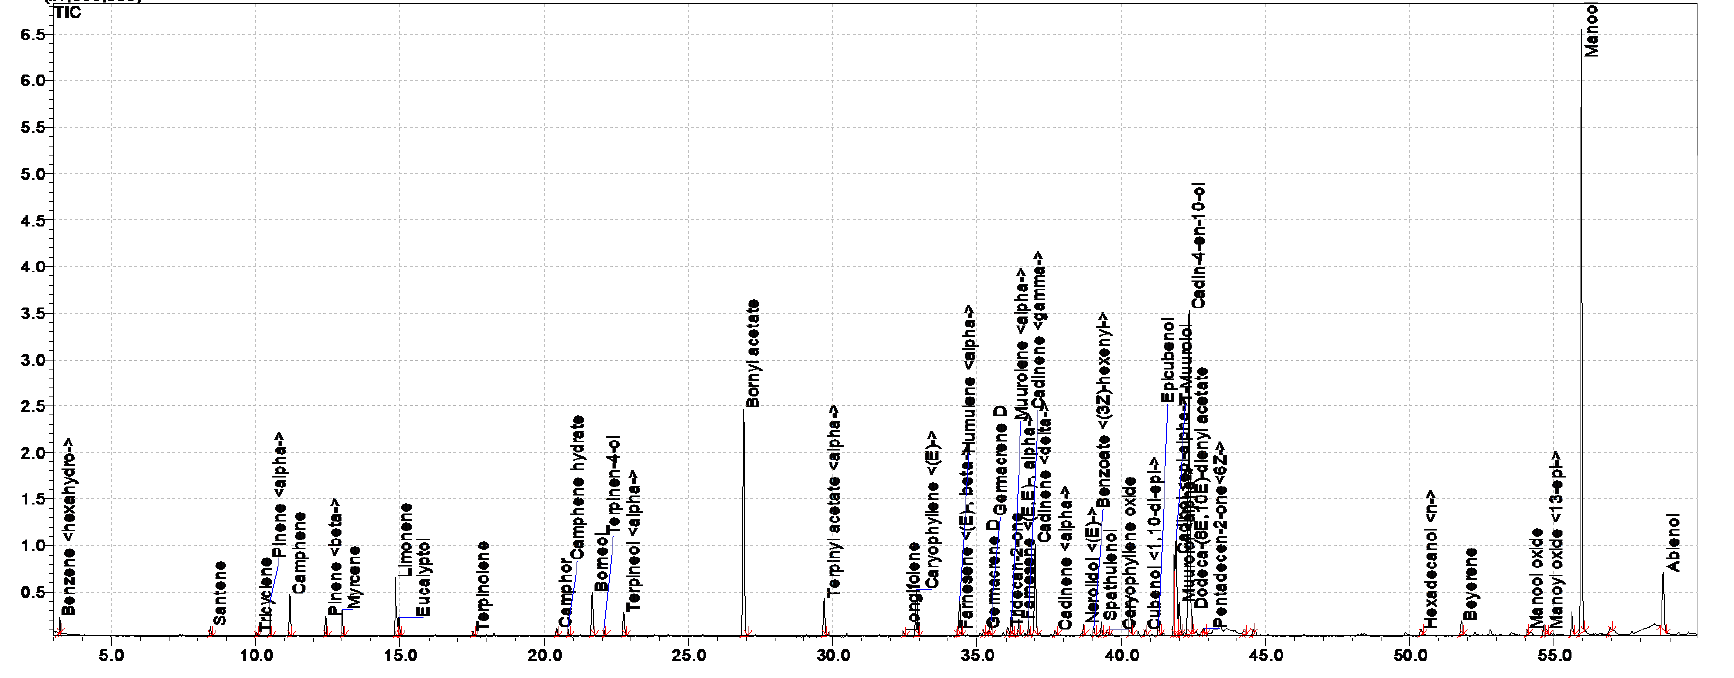
Figure A2. GC-MS chromatogram of essential oil obtained from Picea abies (Lazec, avg.